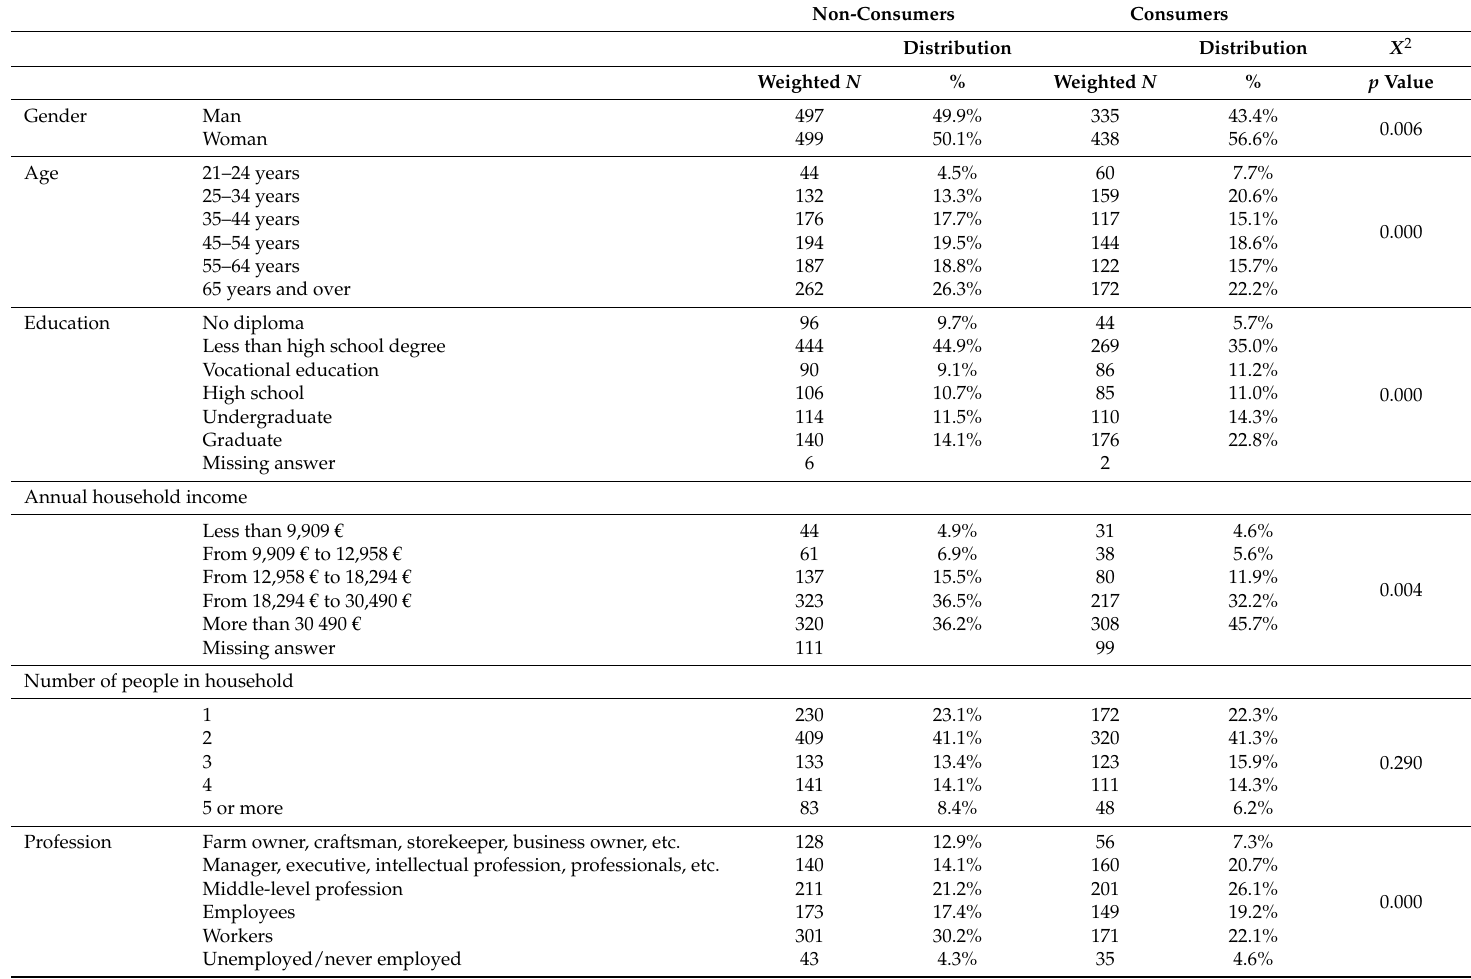
Table 1. Characteristics of consumers and non-consumers of 100% pure fruit juice